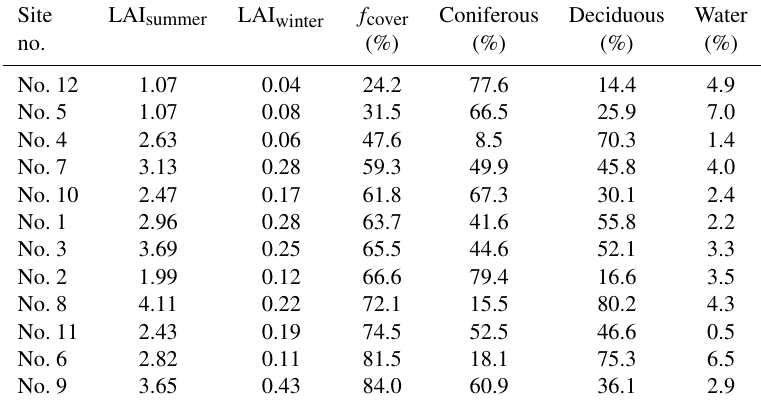
Table 2. LAI summer is the mean of the LAI provided by MODIS for the summer period (1 July to 31 August) and averaged over the AMSR-2 grid cell (10 × 10km 2 ), LAI winter is the mean LAI for the winter period (1 January to 1 March). f cover is the fraction of forest cover within the AMSR-2 grid cell extracted from the land cover map Circa 2000 (see Sect. 3.1.3). The percentages of coniferous, deciduous, and water areas are the percentages distributed within the f cover . Sites are ranked in the increasing order of f cover . The three highlighted sites (gray cells) are the sites selected to test the configuration of the DA scheme in Sect. 3.4.3. Site LAI summer LAI winter f cover